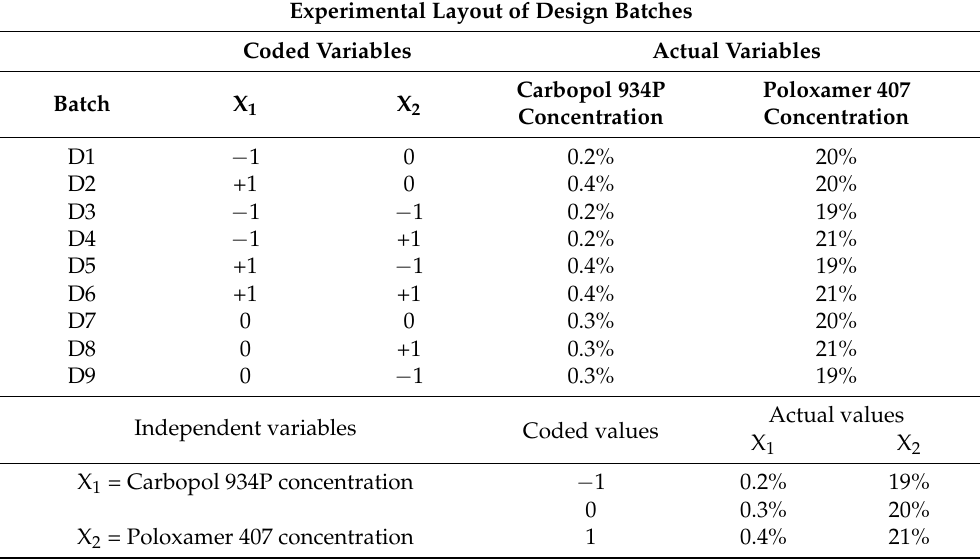
Table 6. The layout of 3 2 full factorial